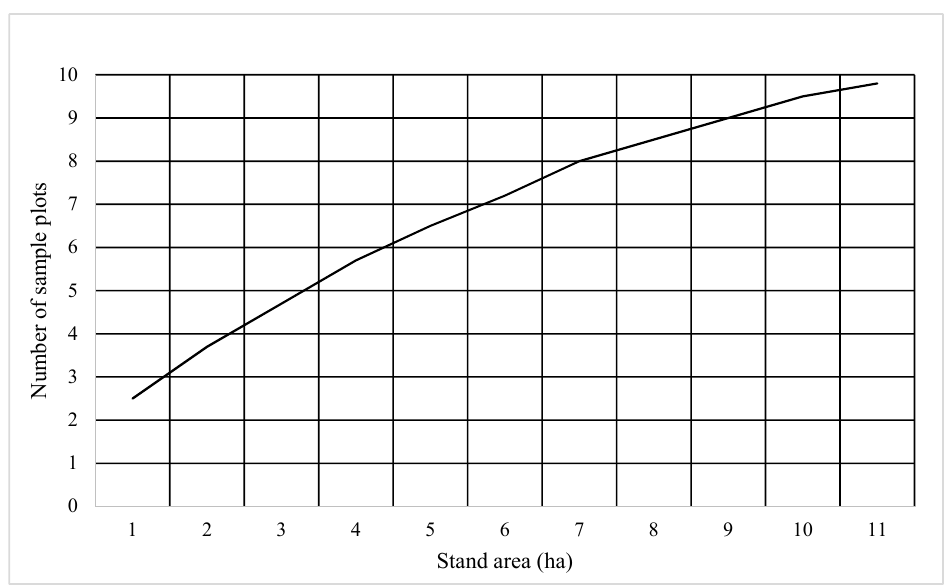
Figure 1. A nomogram designed to determine the number of sample plots in a forest stand [20]. Forests 2020 , 11 , x FOR PEER REVIEW